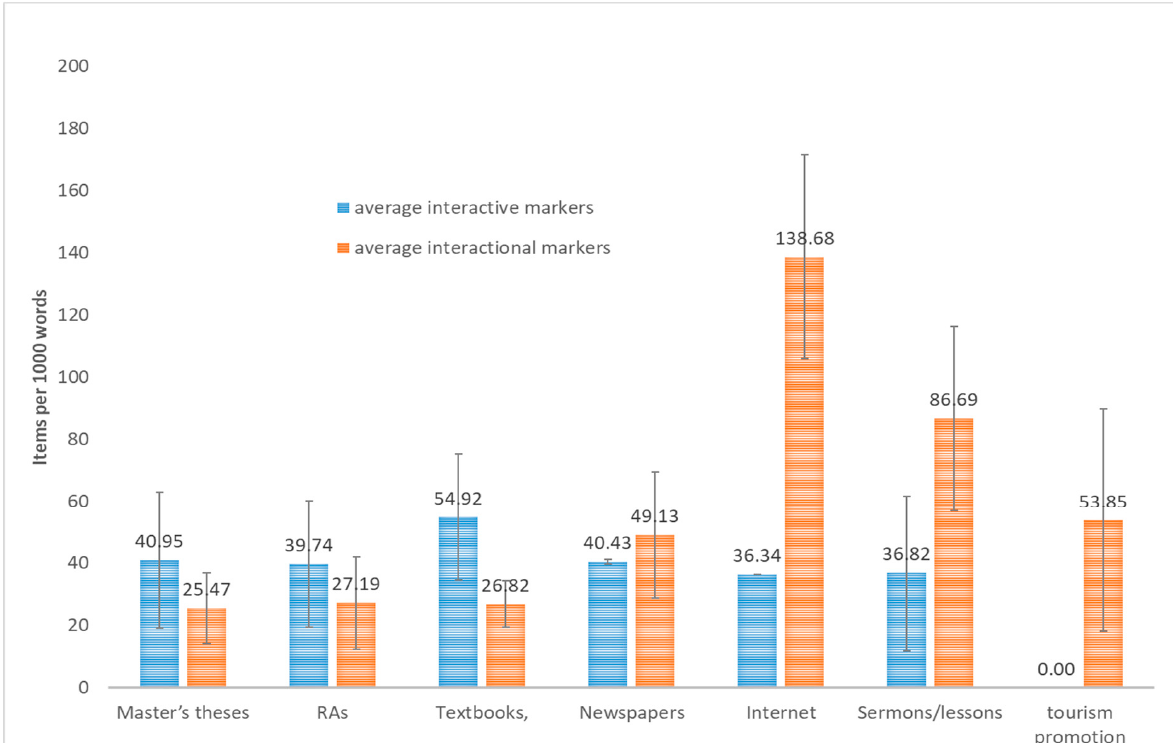
Figure 9. Interactive vs. interactional markers by textual genre (items per 1000 words).